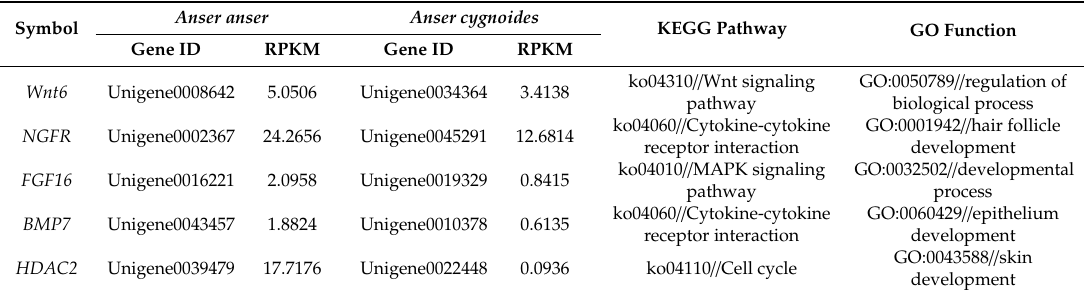
Table 3. The KEGG pathway and GO function of DEGs associated with embryonic skin feather follicle